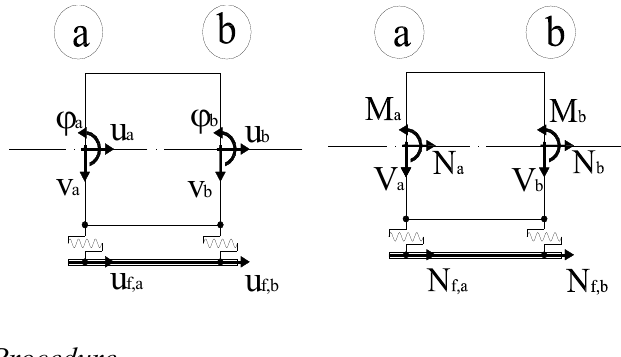
Figure 3. Force and displacement components for the proposed finite element.